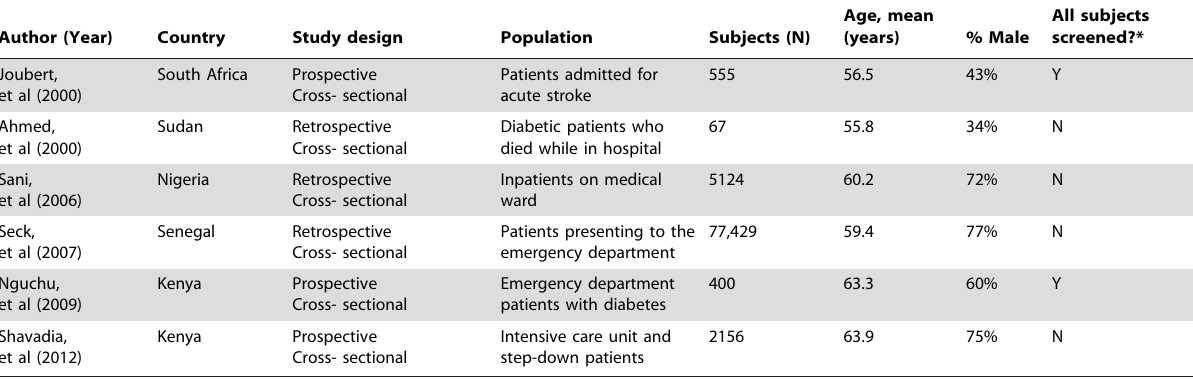
Table 1. Studies